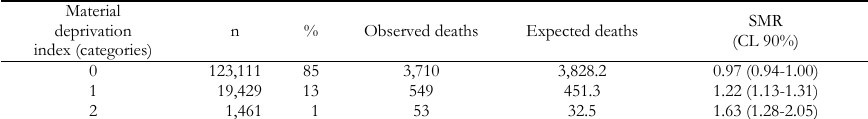
Tuscan Longitudinal Study. Number of enrolled subjects (percentage), observed and expected death counts, SMR (90% confidence limit) by category of material deprivation index. All cause mortality. Males. Florence census cohort